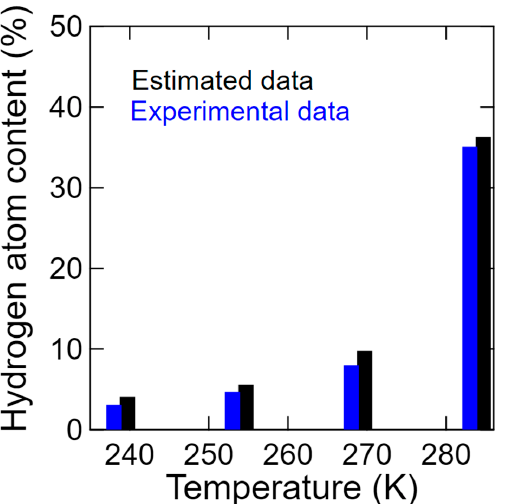
Figure 16. Ratios between the mobile (blue) and immobile (gray) hydrogen atoms experimentally obtained from S D ( Q , ω ) and Equations (5) and (6) (blue); and those estimated using Equation (9) (black) at 238, 253, 268, and 283 K.